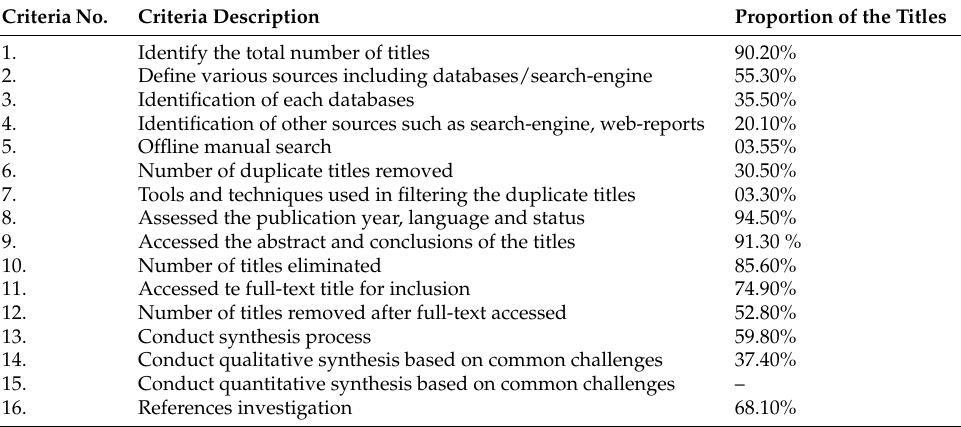
Table 3. Quality assessment criteria and title proportion. Criteria